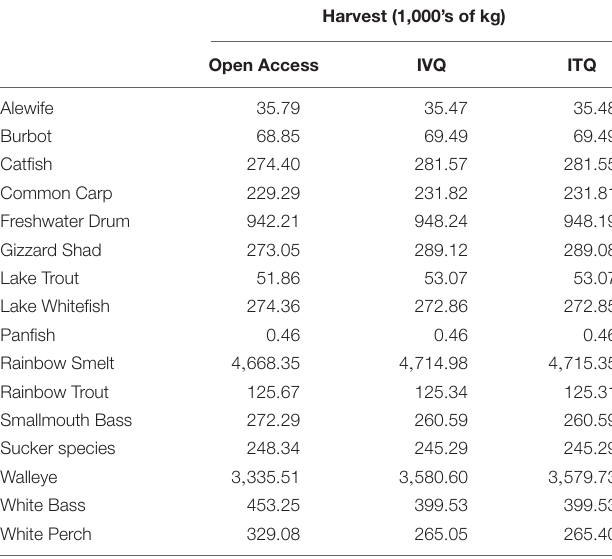
TABLE 4 | Steady state harvest biomasses for all fisheries in Lake